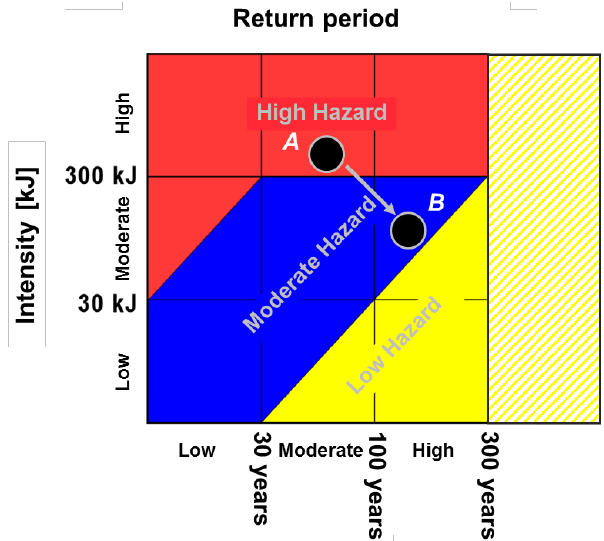
Figure 6. Reclassification of hazard at a given location of the slope, using the Swiss intensity–frequency diagram. Point A is the natural rockfall hazard scenario. Point B is the new hazard level assessed once the effect of a given protection measure is taken into